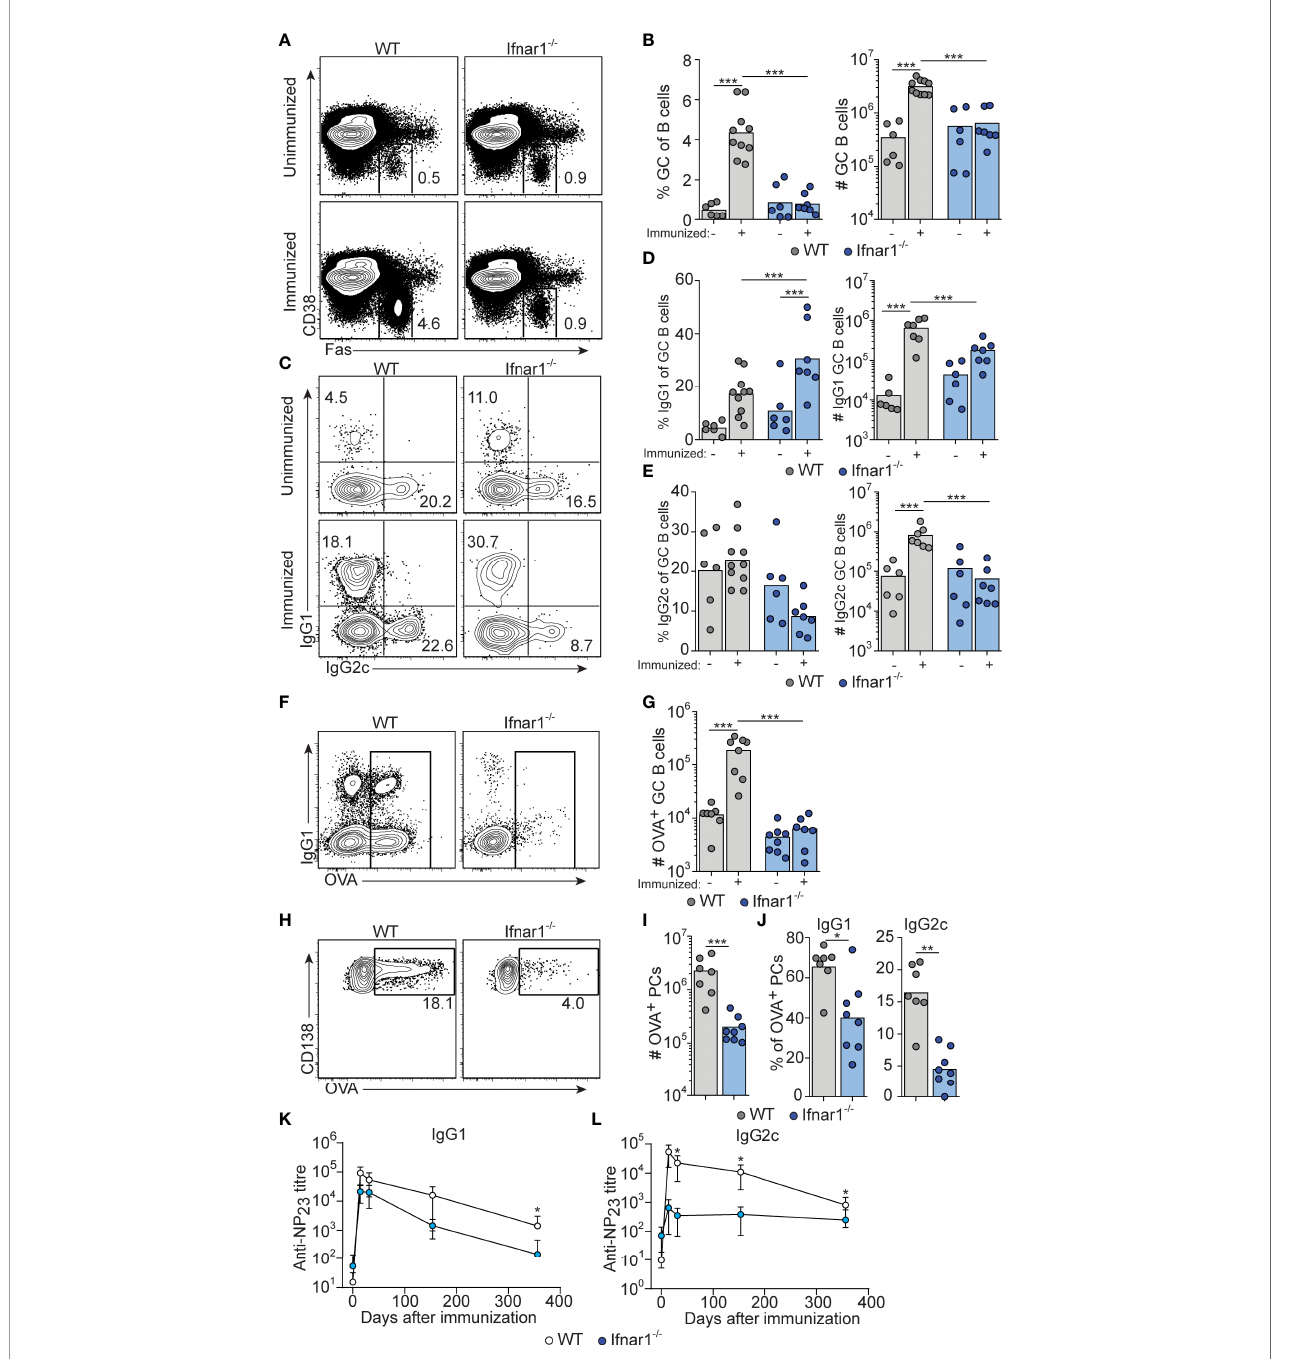
FIGURE 1 | Attenuated GC B cell responses in Ifnar1 -/- mice. WT or Ifnar1 -/- mice were transferred with 5000 OTII cells and immunized with OVA/poly I:C (A – J) or NP-OVA/poly I:C (K, L) . (A – J) Flow cytometry analysis of splenocytes 8 days (A – E and H – J) or 14 days (F, G) after immunization. (A, B) Analysis of GC B cells after gating on total B cells (CD4 - B220 + ). Representative plots (A) and pooled results of percentages and numbers of GC B cells (B) are shown. (C – E) IgG subclass distribution among GC B cells. Representative contour plots of IgG1 versus IgG2c expression (C) and pooled results of percentages and numbers of IgG1 + (D) and IgG2c + (E) GC B cells are shown. (F, G) OVA-binding GC B cells. Representative contour plots of binding of OVA-Alexa647 versus IgG1 expression after gating on GC B cells (F) and pooled results of numbers of OVA-binding GC B cells (G) are shown. (H – J) OVA-binding PCs. Representative contour plots showing intracellular binding of OVA-Alexa647 after gating on B220 low CD138 + PCs (H) , and pooled results of total number (I) and percentage of IgG1 + or IgG2c + (J) OVA-binding PCs. Results are pooled from three (A – E, H – J) or two (F, G) individual experiments and symbols represents individual mice. (K, L) Serum titers of NP 23 -speci fi c IgG1 (K) and IgG2c (L) , before and indicated time points after immunization. Results obtained from one experiment where mice (n=6 per group) were monitored over one year period of time. *p ≤ 0.05, **p<0.01 and